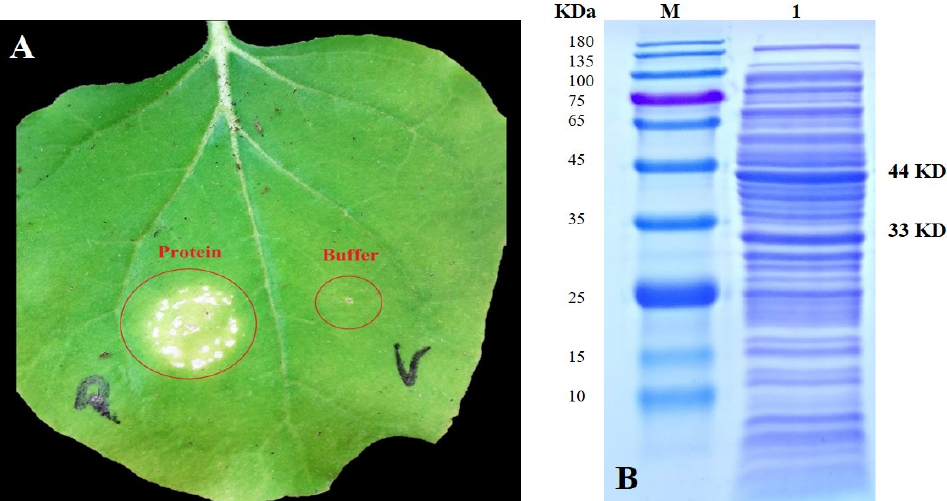
Figure 1. Ion-exchange chromatography exhibited partially purified protein derived by 80% ammo- nium sulphate ((NH ₄ ) ₂ SO ₄ ); ( A ) the necrotic blotch produced by the Lecanicillium lecanii- derived pro- tein (44.62 μ g mL − 1 ) on Nicotiana tabacum leaves photographed 24 h post treatment. In the control, N. tabacum leaves were treated by the 50 mM Tris-HCL with pH 8.0 (mock buffer); ( B ) the L. lecanii- derived proteins purified by the chromatography column on a 12% SDS-PAGE. Lane M indicates the protein molecular weight (kilodaltons) marker.